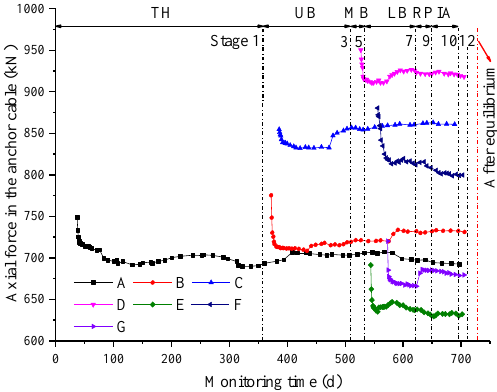
Figure 20. Final distribution of the axial forces in the cables.